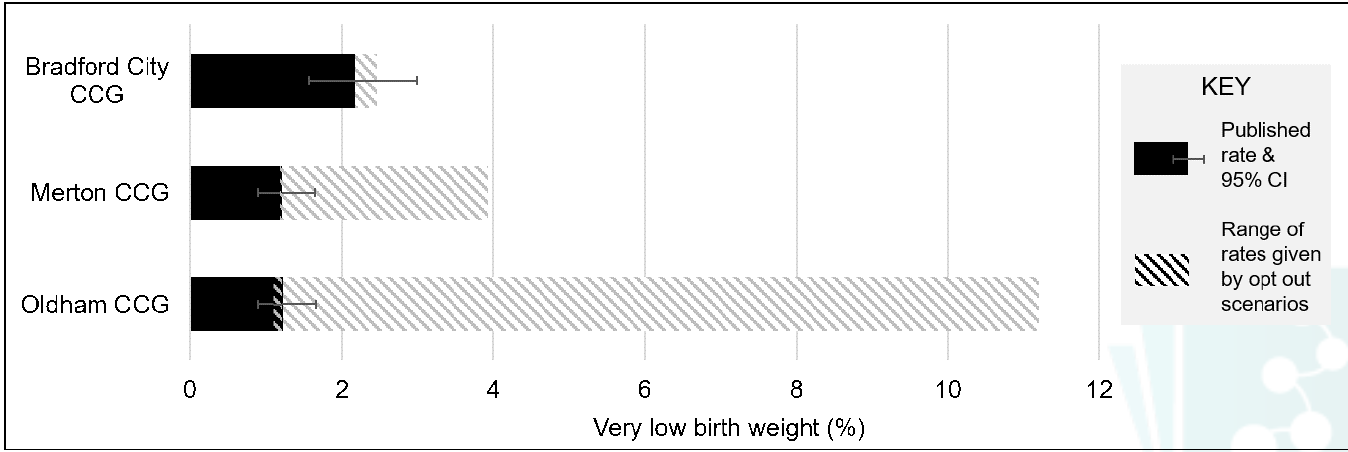
Figure 3: Observed and simulated rates of births with very low birth weight (<1500g) observed and simulated rates: by CCG, 2016 [21,